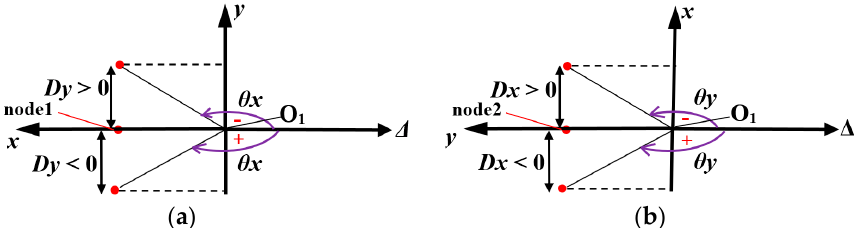
Figure 5. Relationship beween displacement of node 1 ( 𝐷𝑦) , node 2 ( 𝐷𝑥) with value of angle 𝜃 (cid:3051) , 𝜃 (cid:3052) . ( a ) Displacement of node 1 Dy represents position of axis O (cid:2869) x and value of angle 𝜃 (cid:3051) . 𝐷𝑦 > 0 → 𝜃 (cid:3051) < 0, 𝐷𝑦 < 0 → 𝜃 (cid:3051) > 0 . ( b ) Displacement of node 2 𝐷𝑥 represents position of axis O (cid:2869) y and value of angle 𝜃 (cid:3052) . 𝐷𝑥 > 0 → 𝜃 (cid:3051) < 0, 𝐷𝑥 < 0 → 𝜃 (cid:3051) > 0 .